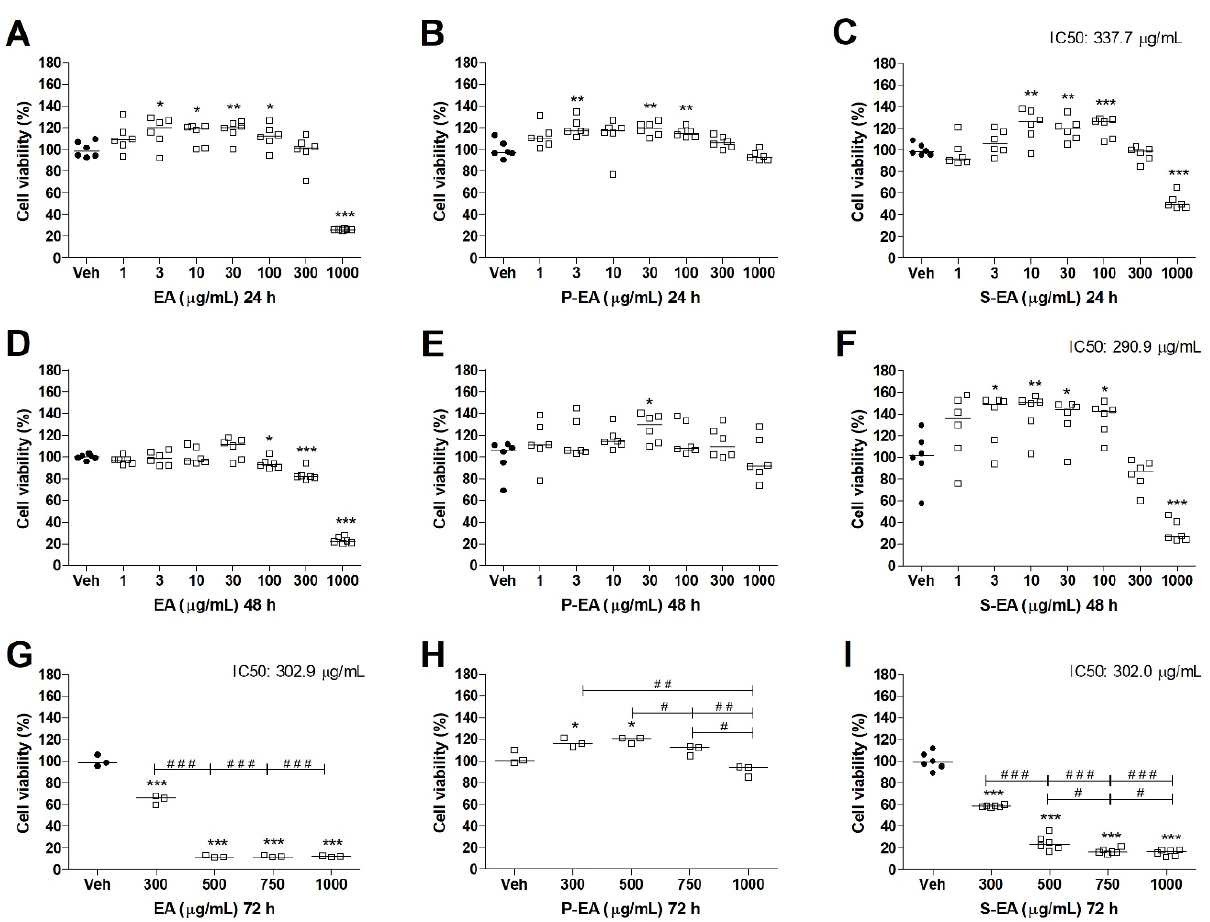
Figure 7. Cell viability determined by MTT assay of MCF10A cell line treated with EA ( A , D , G ), P-EA ( B , E , H ), and S-EA ( C , F , I ). Cells were incubated with the extracts (1, 3, 10, 30, 100, 300, or 1000 µ g/mL) for 24 h and 48 h, and 300, 500, 750, or 1000 µ g/mL for 72 h. Statistical analyses were performed by unpaired t -test. The results represent the median of three independent experiments ( n = 3–6). * p < 0.05; ** p < 0.01; *** p < 0.001 compared to vehicle group (control group). # p < 0.05; ## p < 0.01; ### p < 0.001 comparison with indicated pairs.